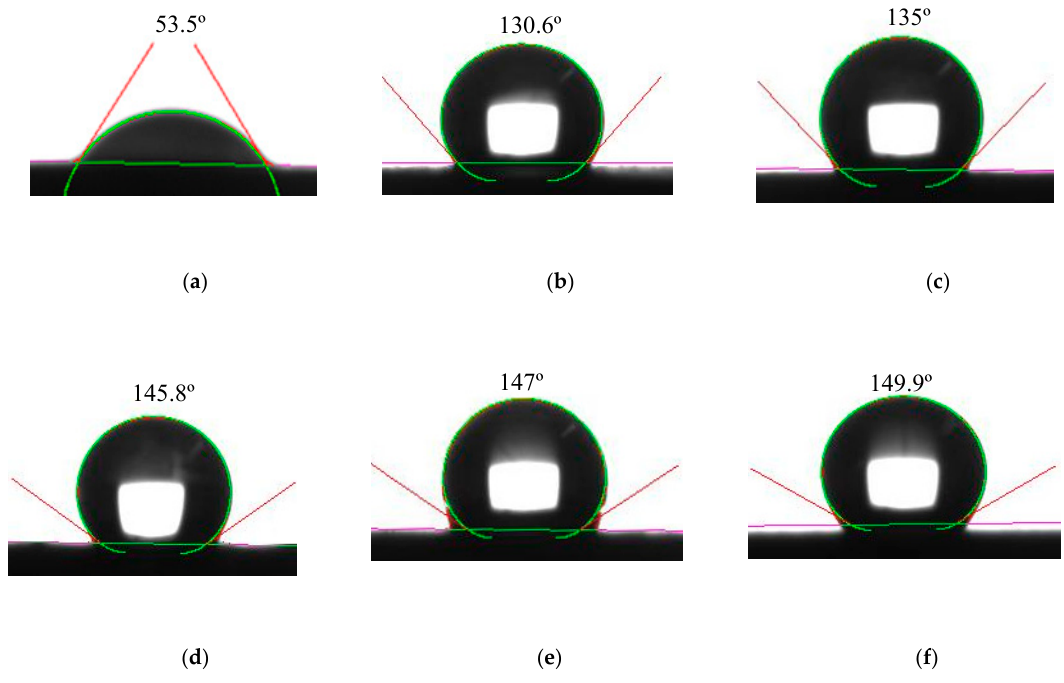
Figure 5. Water contact angle of copper-plated wood veneer, ( a ) is the original wood; ( b ) Magnetron sputteringfor50s; ( c )Magnetronsputteringfor150s; ( d )Magnetronsputteringfor10min; ( e )Magnetron sputtering for 15 min; ( f ) Magnetron sputtering for 15 min (200 ◦ C). Table 3. Contact angle and standard deviation of surface of wood veneer before and after coating.